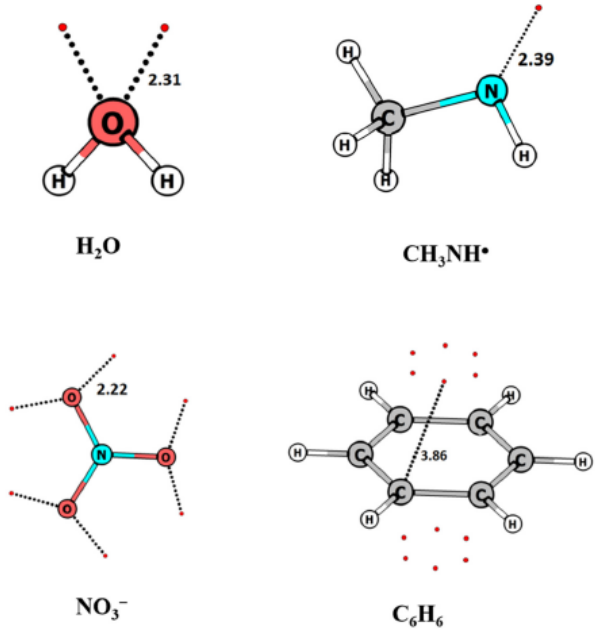
Figure 6. MESP topography of H2O, CH3NH · , NO 3 − and C 6 H 6 employing MP2/6-311++G(d, p) calculations. Minima shown by red dots. The distance is in